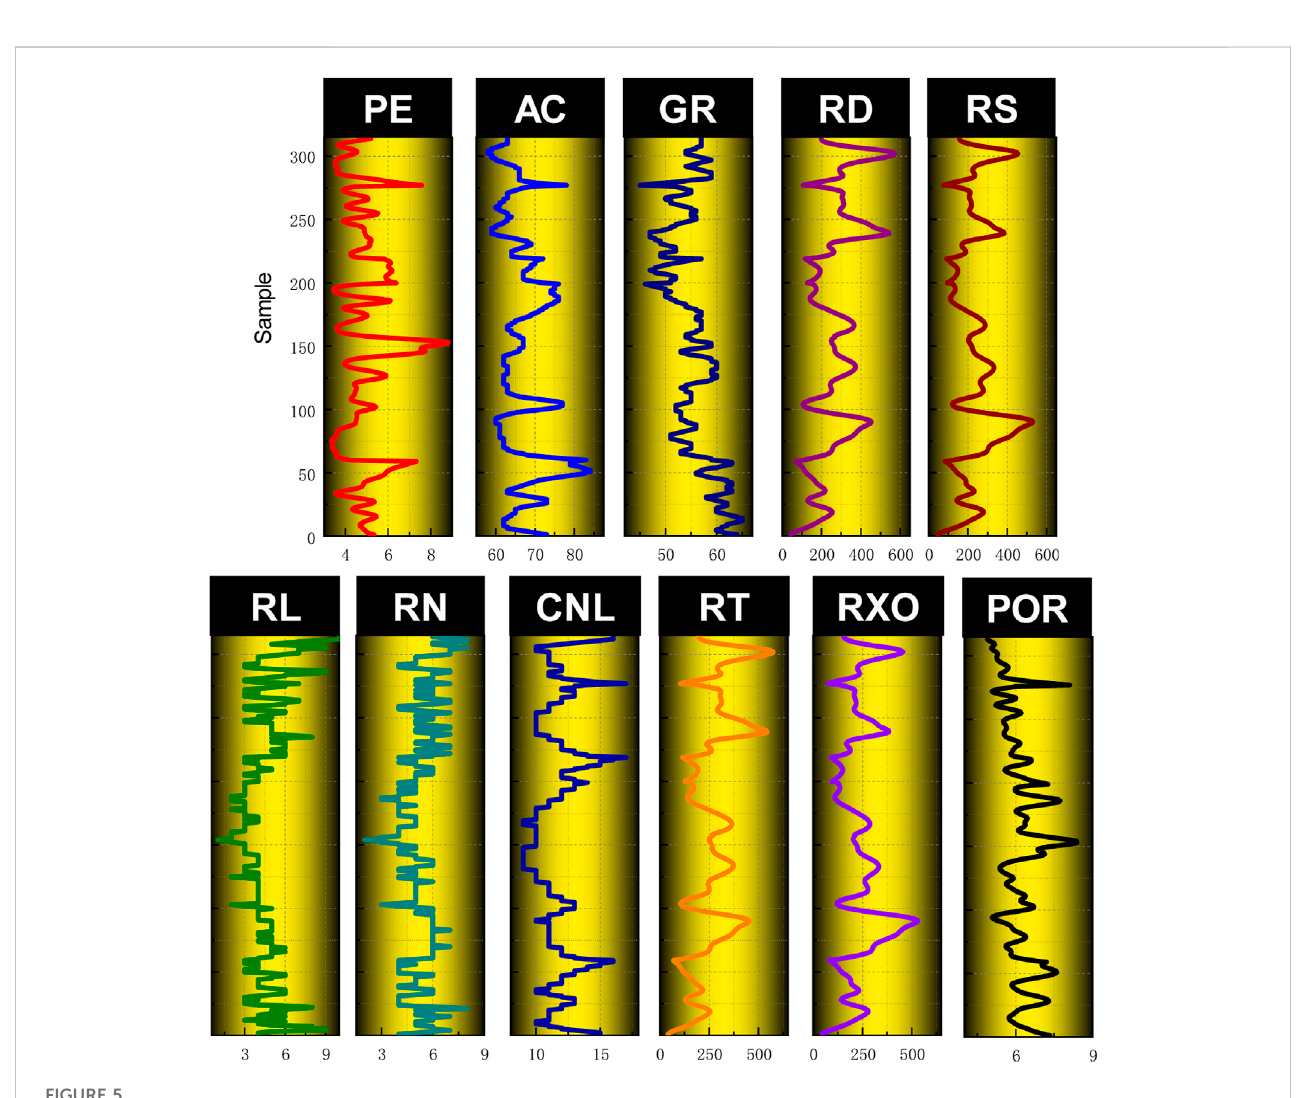
FIGURE 5 Logging parameters and porosity logging